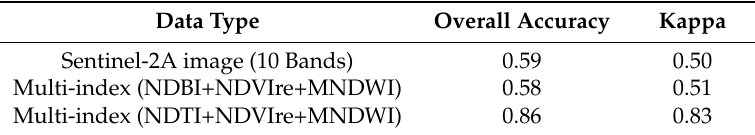
Table A6. Comparison of the overall accuracy and Kappa statistics for Figure